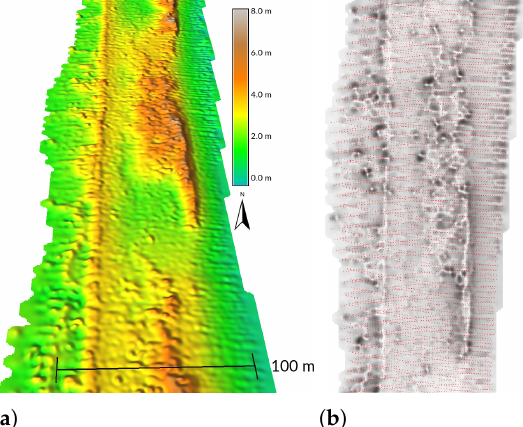
Figure 10. Corduroy effect visible on ( a ) the interpolated DEM visualized in 3D and ( b ) the source point cloud (red) overlaid with a DEM-derived skyview factor visualization [71] that shows the low places between corduroy ridges in dark gray. The DEM was interpolated at 0.5 meter resolution. Dataset: NASA/USGS 2003 [46].